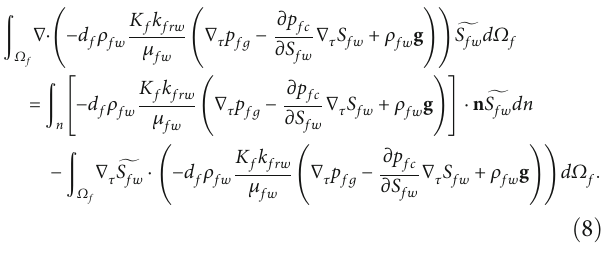
and fractures Ω